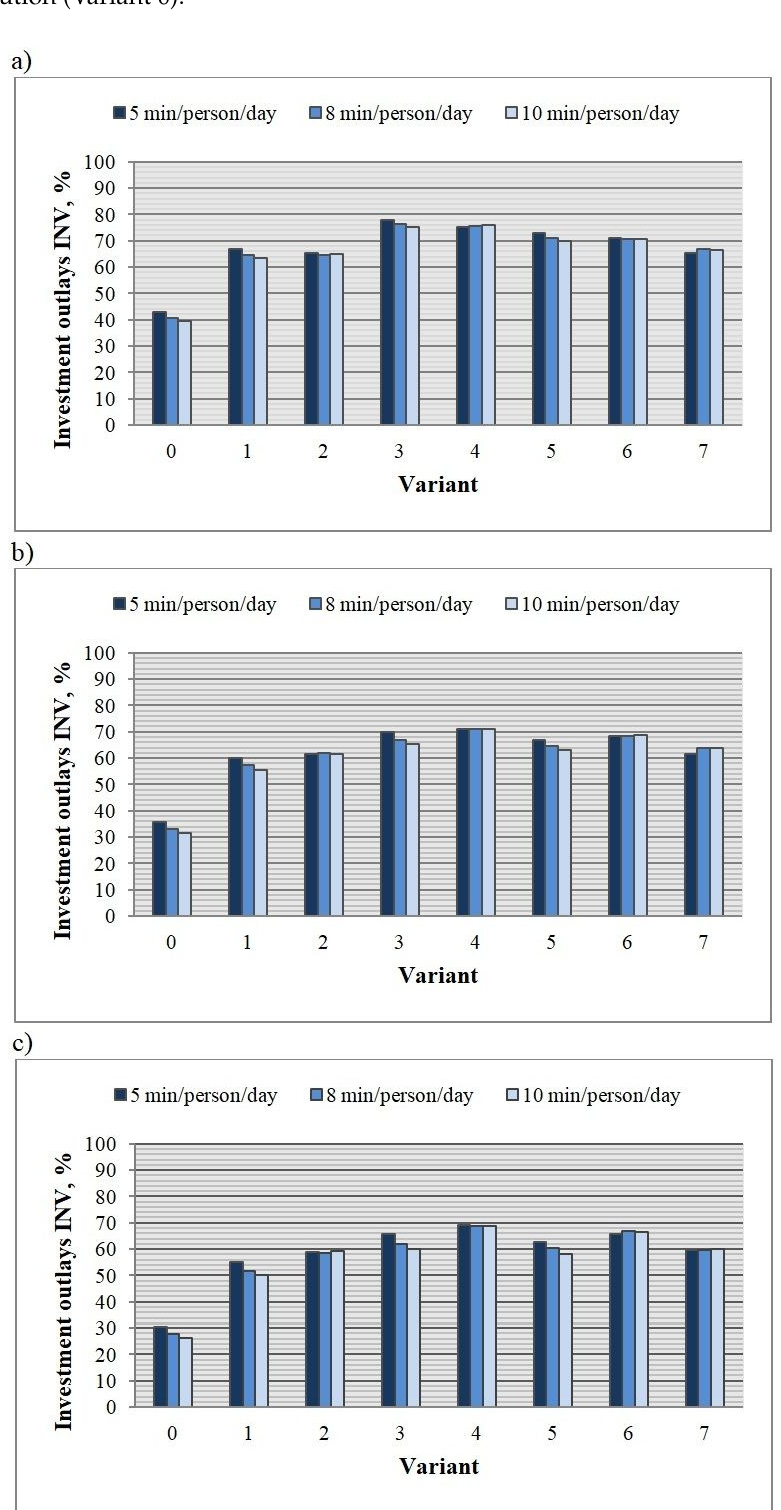
Figure 13. The amount of INV capital expenditure depending on the installation variant for ( a ) O c = 2 persons, ( b ) O c = 4 persons, ( c ) O c = 6